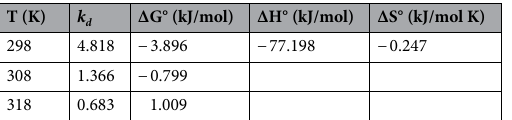
Table 3. Thermodynamic parameters for PNP adsorption on TMA-(PA6- g -GMA).